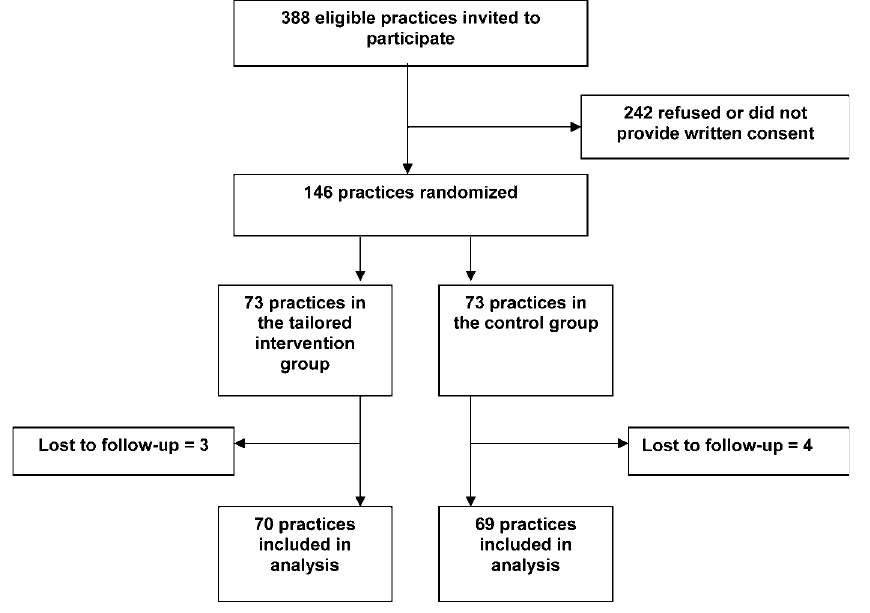
Figure 1. Design of Cluster-Randomized